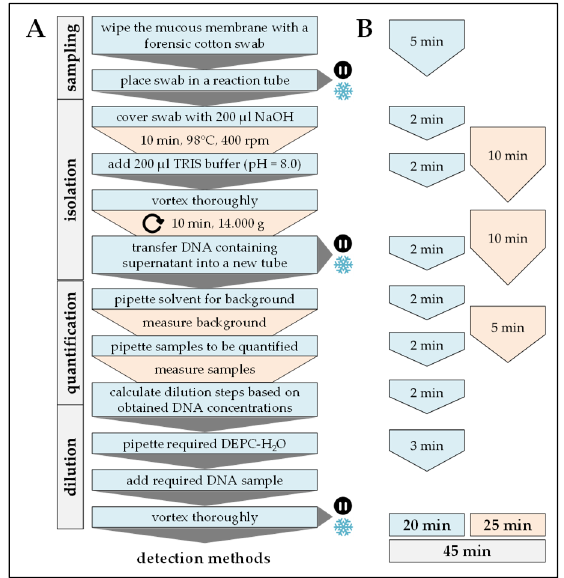
Figure 1. Workflow and timing of DNA sampling and isolation. In ( A ) workflow and ( B ) timing the blue color marks handling steps (time) of the experimenter and the orange color marks pause times caused by the procedure. Procedure can be stopped at this step. Store samples at − 20 °C/prevents repetitive freeze and thaw cycles.